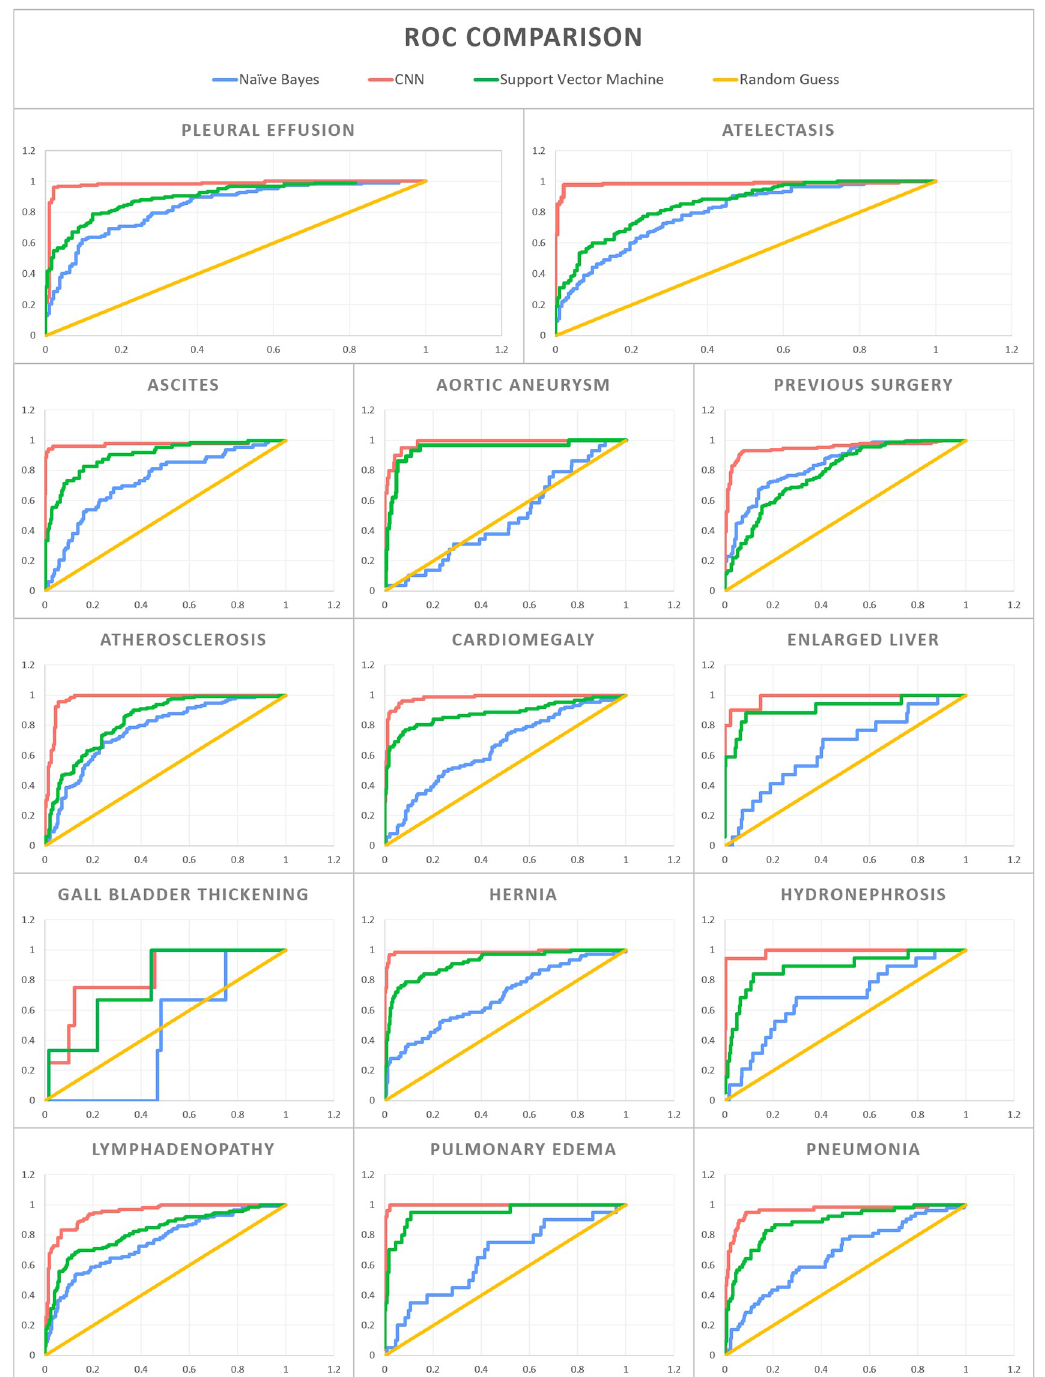
Fig 2. Receiver Operator Characteristic (ROC) curves for the 14 pre-selected radiographic findings. The Convolutional Neural Network (CNN) is compared to Naive Bayes, Support Vector Machine (SVM), and random guessing.